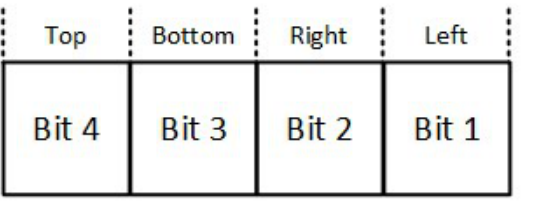
Figure 17. Outcode bits for the Midpoint Subdivision algorithm. There are three possible cases for any given